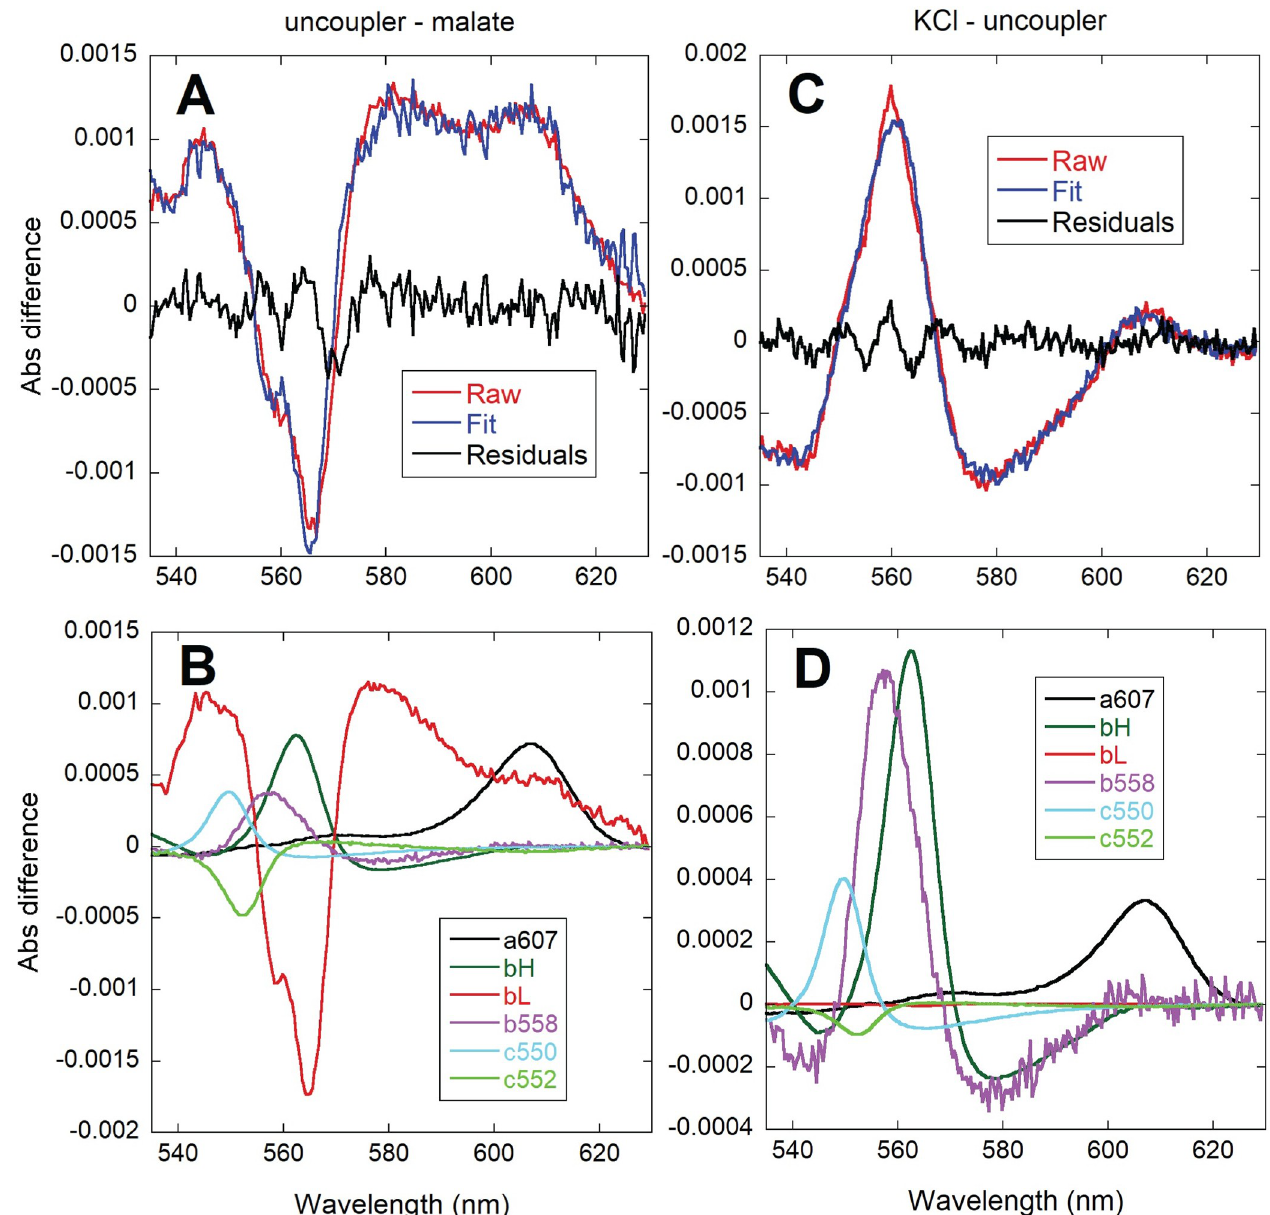
Fig 9. Comparison of the absorbance changes induced by the addition of 3 μ M DBNP after 16.5 mM sodium malate (left, A and B) and 20 mM KCl after DBNP (right, C and D). Difference spectra of 8.4 x 10 9 /ml CyoB - /CcoN - K + depleted cells were calculated relative to the steady state after sodium malate addition (left) or relative to the steady state after uncoupler addition (right). 200 spectra collected every 0.5 s were averaged for each condition and the resulting averaged spectra were subtracted as indicated (uncoupler-malate or KCl-uncoupler). The top panels (A and C) show the fit (blue) of the raw spectral data (red) and the residuals of the fit (green). The bottom panels (B and D) show the contribution of each cytochrome reference to the fitted